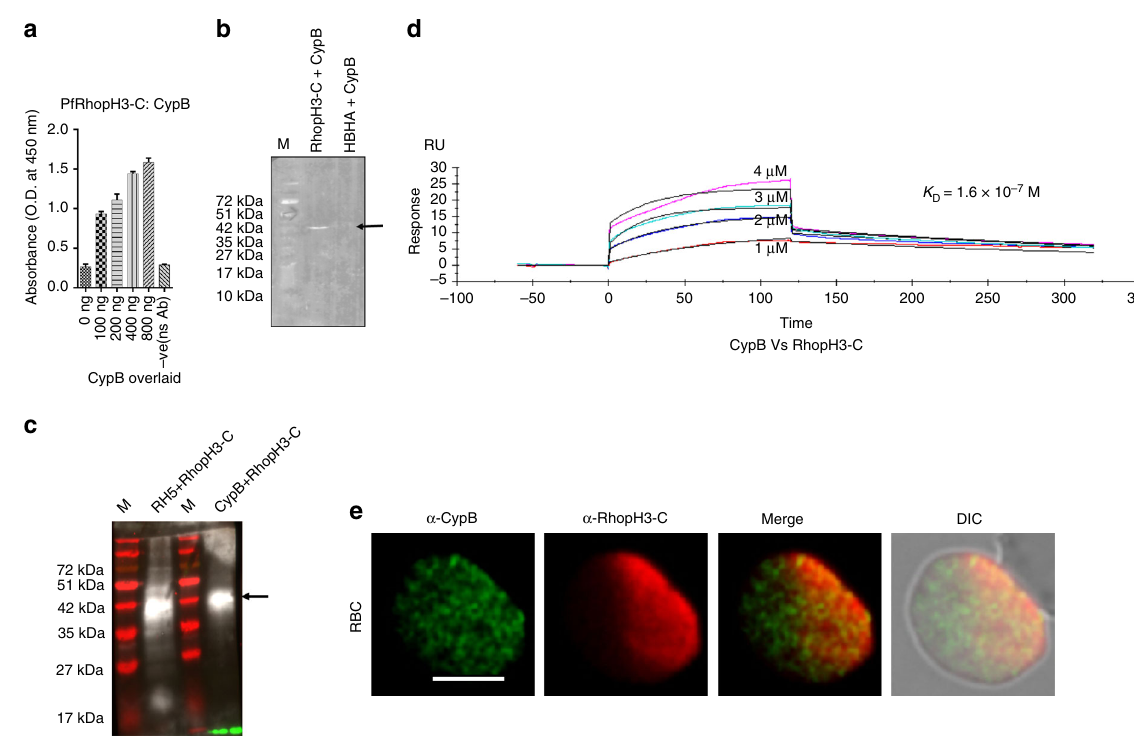
Fig. 3 Protein − protein interaction assays con fi rm the interaction between Cyclophilin B and PfRhopH3-C. a ELISA-based assay con fi rming the interaction between CypB and PfRhopH3-C. 200 ng of PfRhopH3-C protein was coated on ELISA plates. CypB was overlaid on subset of wells in increasing concentrations as shown, and detected by anti-CypB (rabbit polyclonal) antibody followed by HRP conjugated secondary anti-rabbit antibody. A non- speci fi c antibody ((nsAb) anti-CFP10 rabbit polyclonal) was used as the antibody control. Negative control for this ELISA experiment is shown in Supplementary Fig. 5d. Each bar represents the mean ± S.D. for triplicate experiment. b Far-western analysis. PfRhopH3-C was run on SDS-PAGE and transferred onto PVDF membrane and following denaturation and renaturation, incubated with CypB protein. CypB protein (indicated by arrow) was detected by anti-CypB (rabbit polyclonal) antibody. Mycobacterial protein HBHA was used as the negative control protein. c Co-immunoprecipitation of PfRhoph3-C with CypB and PfRh5. Antibody coupling resin bound with CypB and PfRh5 antibodies was incubated with CypB:PfRhopH3-C and PfRh5: PfRhopH3-C mixtures, respectively. Eluted samples were run on SDS-PAGE followed by western blotting. Detection of protein PfRhopH3-C (indicated by arrow) was carried out using anti-PfRhopH3 (rabbit polyclonal) antibody (1:5000). CFP10 was used as the negative control protein. d Surface plasmon resonance analysis of CypB and PfRhopH3-C interaction. The indicated concentrations of puri fi ed PfRhopH3-C were injected over immobilized CypB, and biophysical parameters were derived from a 1:1 binding model. RU, response units. K D value for this interaction was 1.6 × 10 − 7 M. e Binding and co- localization of PfRHopH3-C on the RBC surface. Uninfected RBCs were incubated with 20 μ M PfRhopH3-C and stained with anti-RhopH3-C antibody (rabbit) and anti-CypB antibody (mouse). Subsequently, secondary anti-rabbit alexa- fl our 594 antibody and anti-mouse alexa- fl our 488 antibody were used to detect the co-localization of the proteins. Scale bar = 5 µ